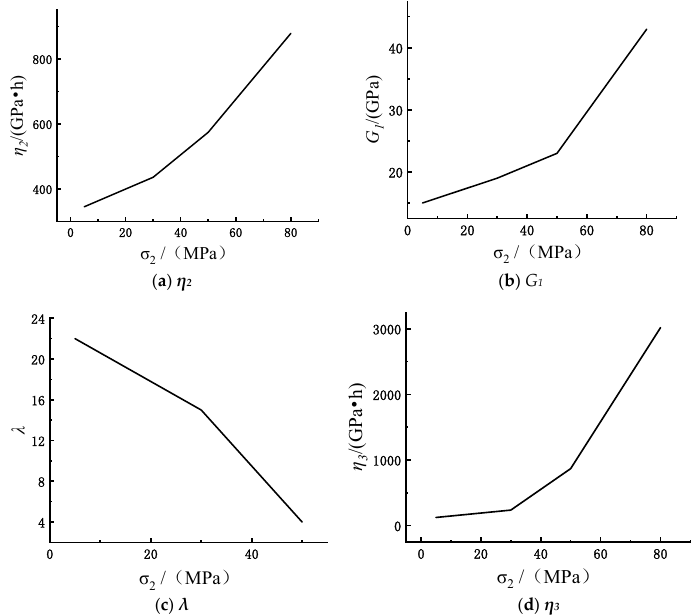
Figure 6. Effects of different intermediate principal stresses on model parameters.